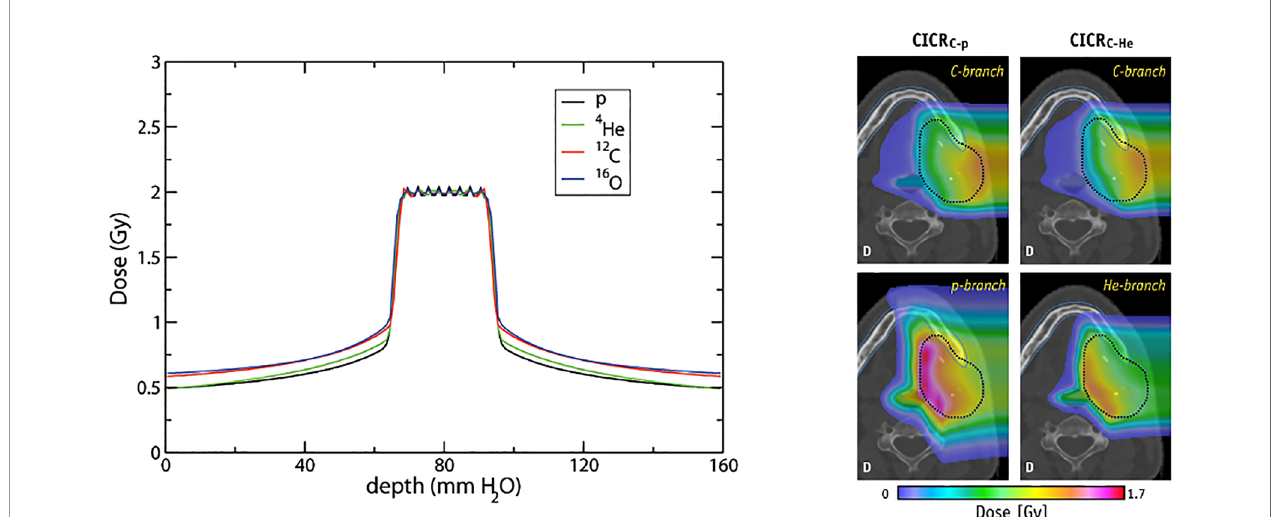
FIGURE 13 | Conformal distributions can be produced by applying opposed fi elds using different particle types, optimizing for physical dose (left) (201). Combining beams of multiple particle types can generate distinctly different dose distributions, by positioning a chosen particle branch (p or He) at the distal end of the fi eld (202). Images distributed under CC BY 4.0,